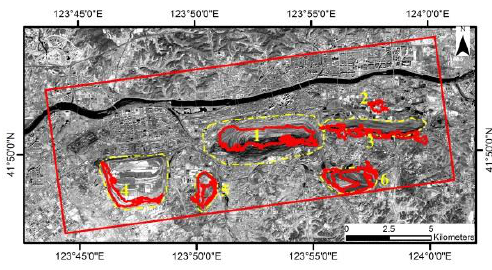
Figure 5 Distribution of deformation areas with rising elevation using ZY-3 DEM in 2015 and ASTER GDEM.